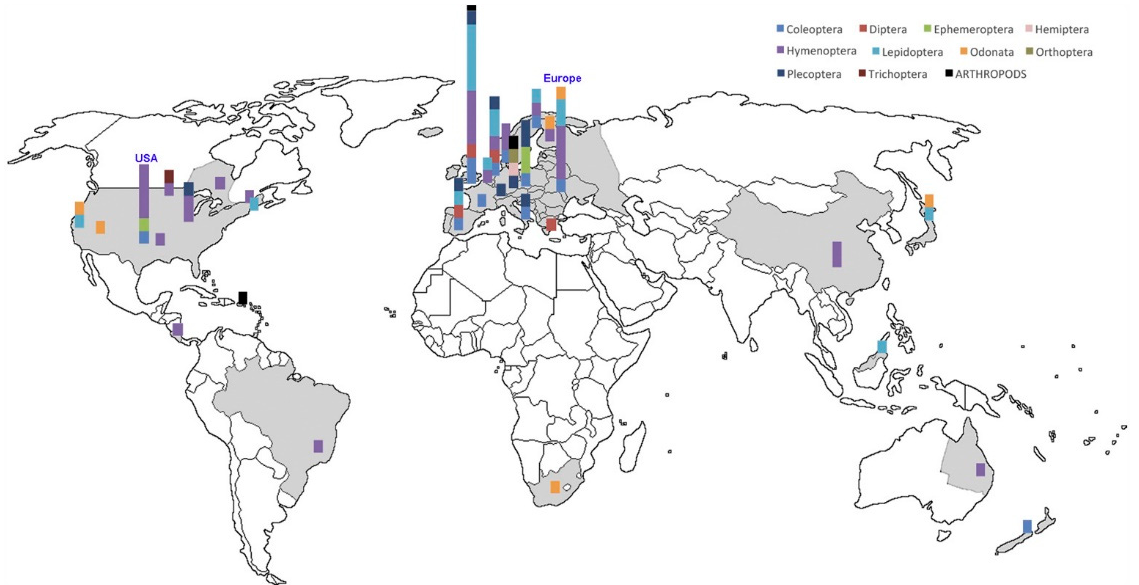
Figure 1. Geographic location of the 73 reports studied on the world map. Columns show the relative proportion of surveys for each taxa as indicated by different colours in the legend. Data for China and Queensland (Australia) refer to managed honey bees only; from [17].